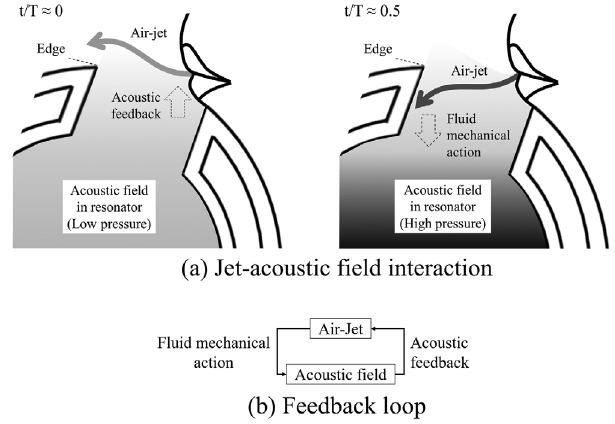
Figure 1. Feedback loop between jet and acoustic fi